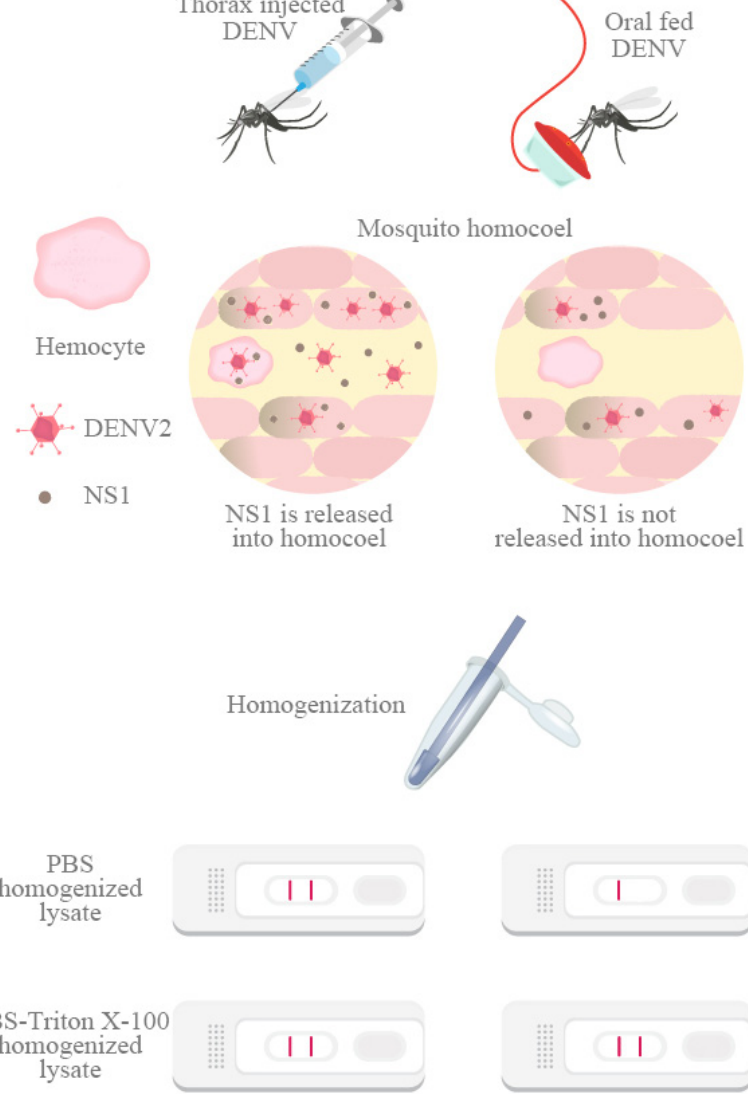
Figure 4. NS1 distribution could be di ff erent in intrathoracically and orally infected mosquitoes. Mosquitoes were infected intrathoracically or orally with DENV2. After homogenization, NS1 could be detected in both PBS and Triton X-100-PBS lysates of intrathoracically infected mosquitoes; however, in the orally infected mosquitoes, NS1 could be detected only following Triton X-100-PBS treatment.